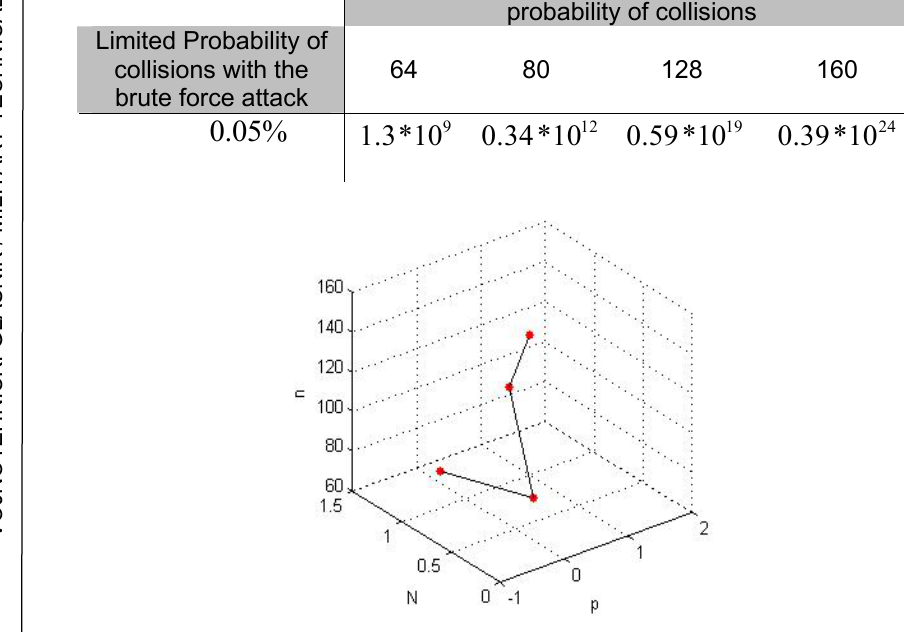
Figure 8 – A 3D graphic presentation for maximum number of users